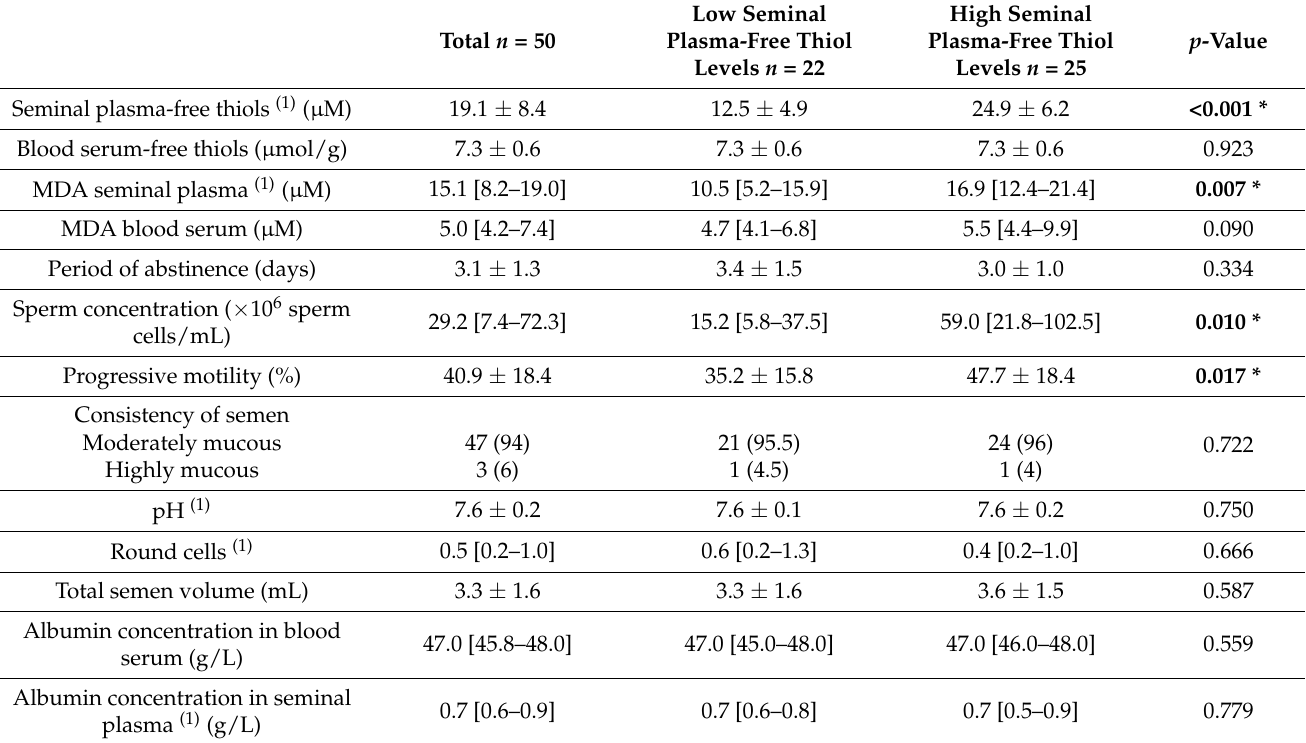
Table 2. Laboratory results of the study